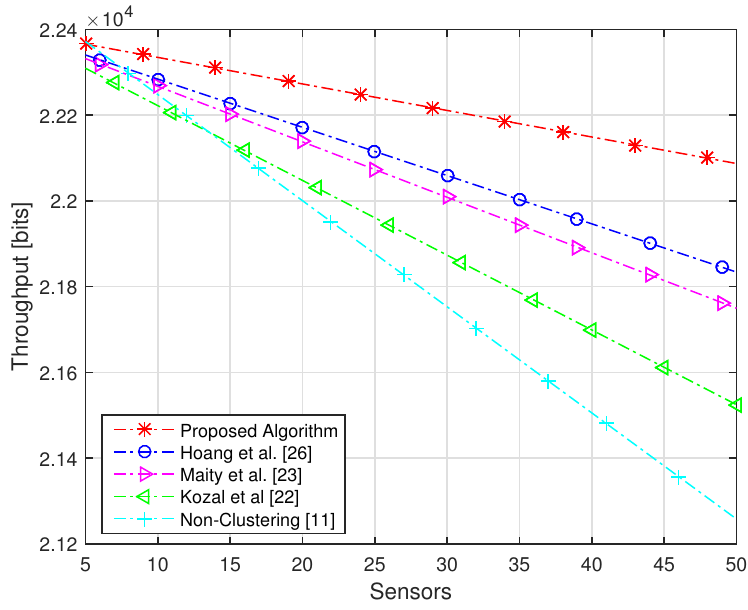
Figure 5. Throughput with an increasing number of sensors.